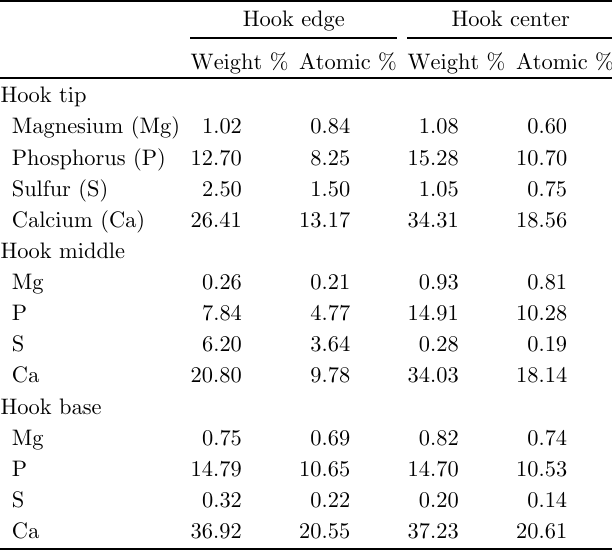
Table 4. Chemical elements for 3levels (tip, middle, base) of gallium cut hooks of Neoandracantha peruensis .